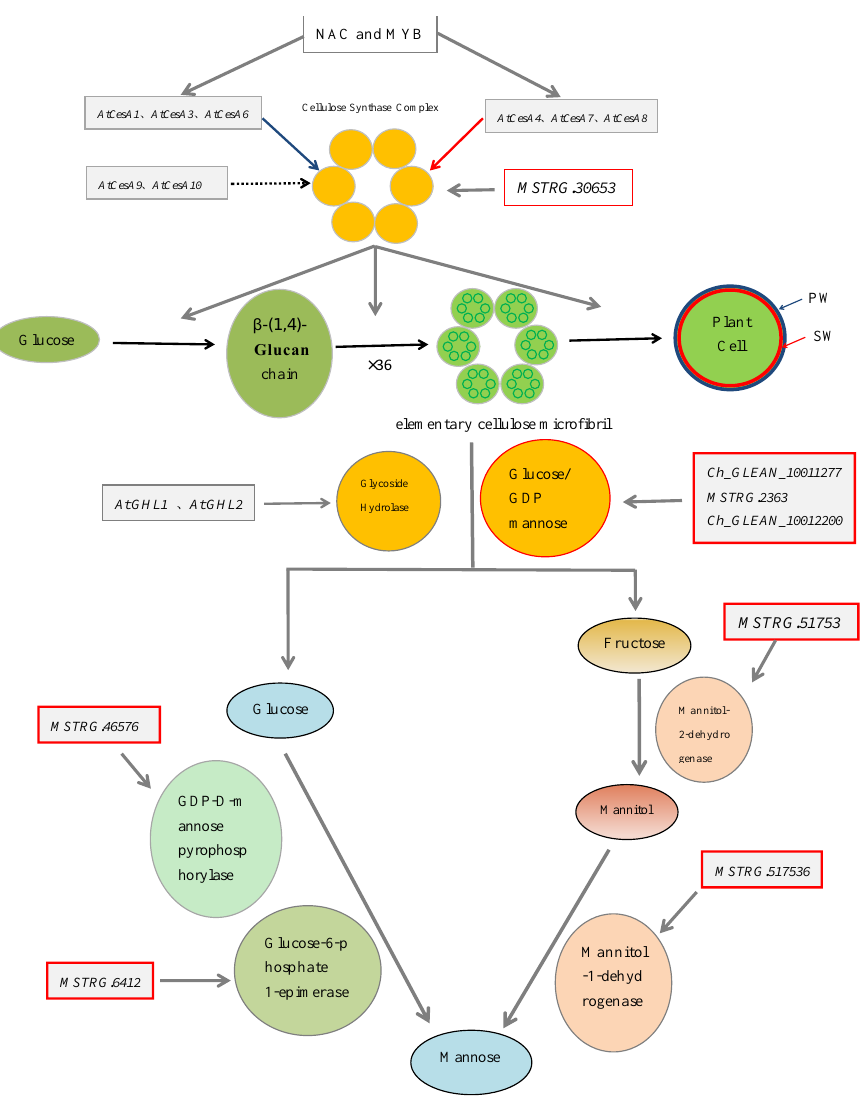
Figure 1. The putative metabolic pathways of mannose. Note: PW is the primary cell wall, SW is the secondary cell wall. Red arrow and the red cell wall means the cellulose in SW is regulated by these genes, and the blue arrow and the blue cell wall represent the cellulose in PW is generated by the corresponding genes. The genes in the red boxes are genes related to our study.